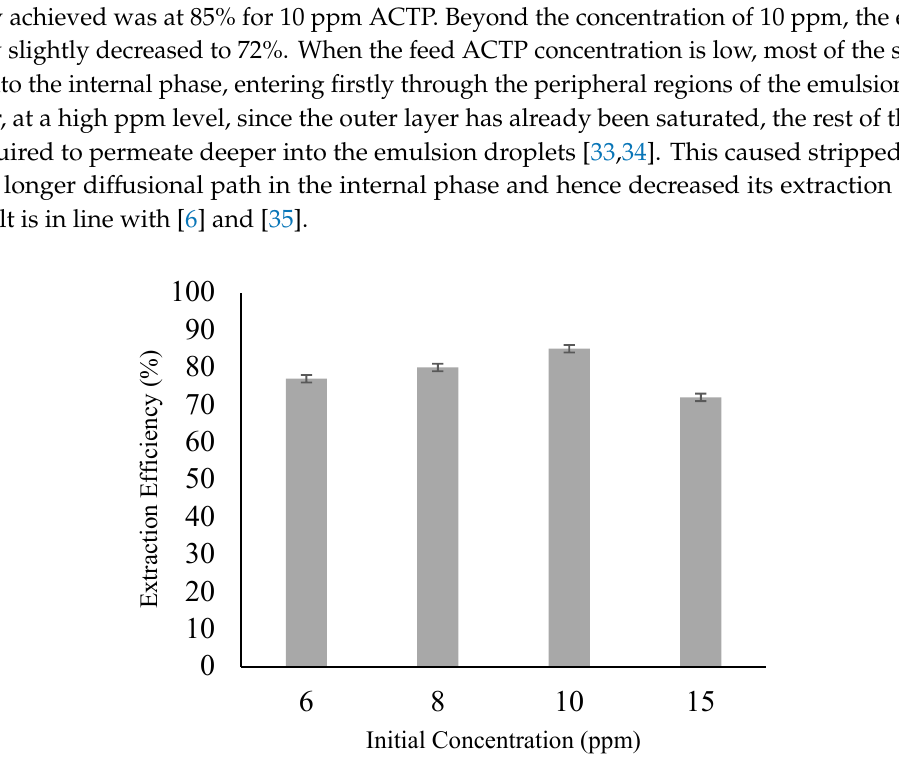
Figure 5. Effect of HCl concentration (Experimental condition: [Ammonia] = 0.1 M ; [TOA] = 6 wt% ; [Span 80] = 6 wt%; Volume Ratio = 3:1 ; Stripping Agent = Ammonia ; Diluent = Kerosene) .